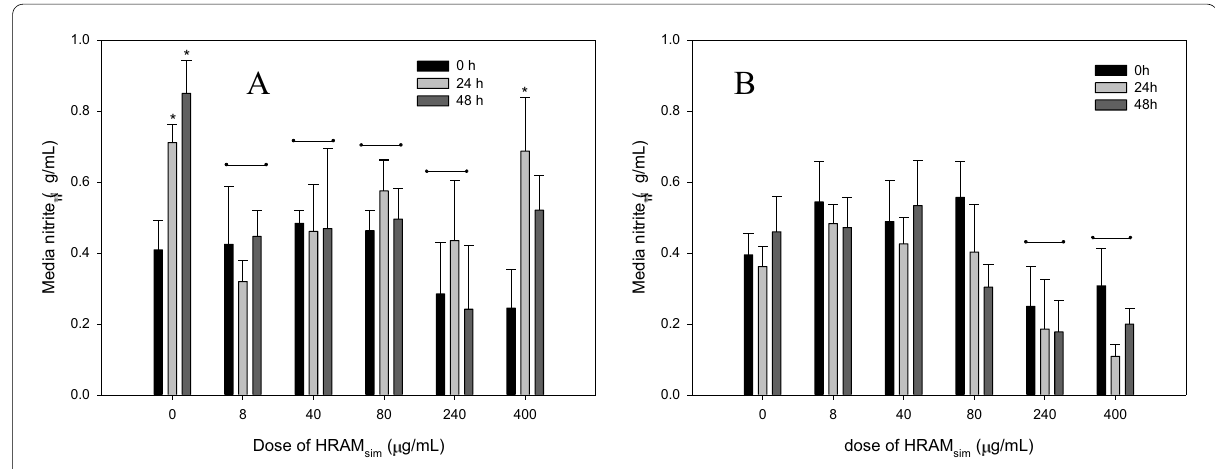
Figure 3 Nitric Oxide [NO] production by cartilage explants stimulated with LPS [3 or 0 μg/mL; Panels A and B, respectively] . Explants were conditioned with HRAM sim [0, 8, 40, 80, 240 or 400 μg/mL] for 96 h, and were stimulated with LPS for the final 48 h. Data shown are for the final 48 hours only. * represents significant effect of LPS; -- represents treatments significantly different from